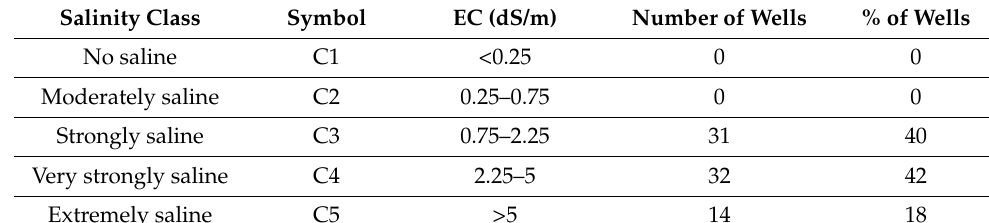
Table 2. Classification of irrigation water based on electrical conductivity.